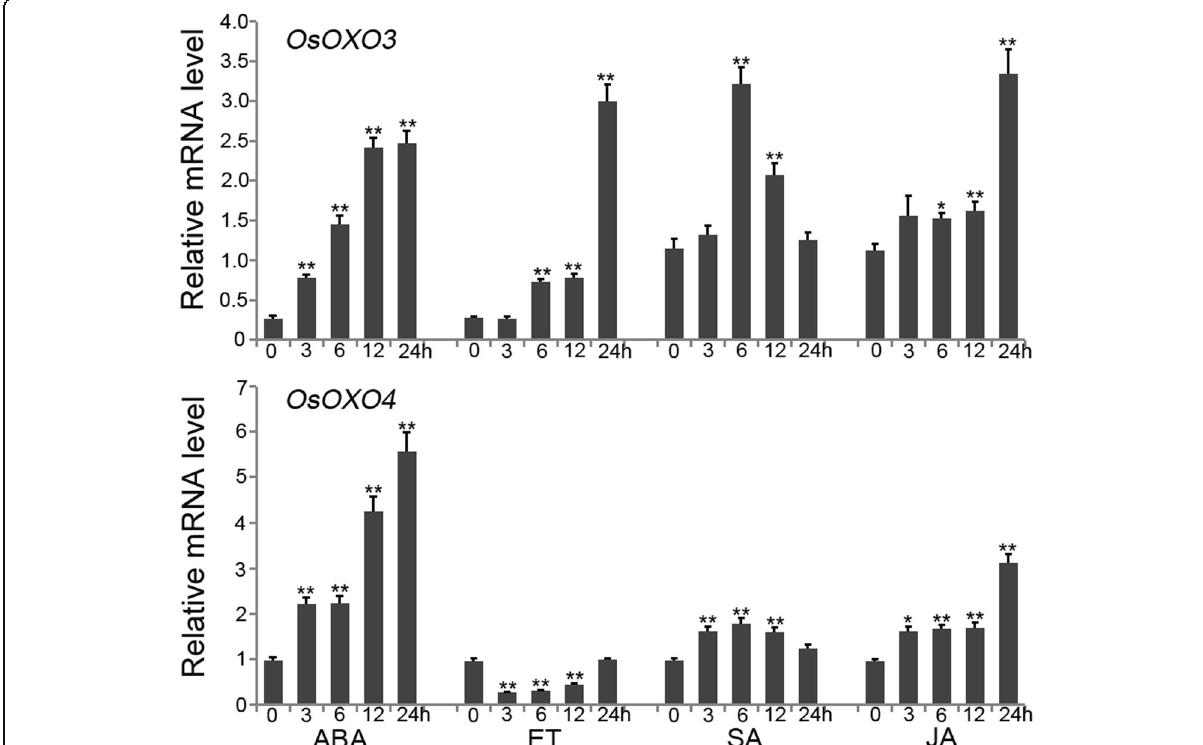
Fig. 6 Time-course transcription analysis of OsOXO3 and OsOXO4 in leaves after abscisic acid (ABA), ethylene (ET), salicylic acid (SA), jasmonic acid (JA) treatments by quantitative RT-PCR. Error bars indicate the SD from three biological replicates and asterisks indicate statistically significant differences compared with water treatment ( t test, ** P < 0.01 and * P <